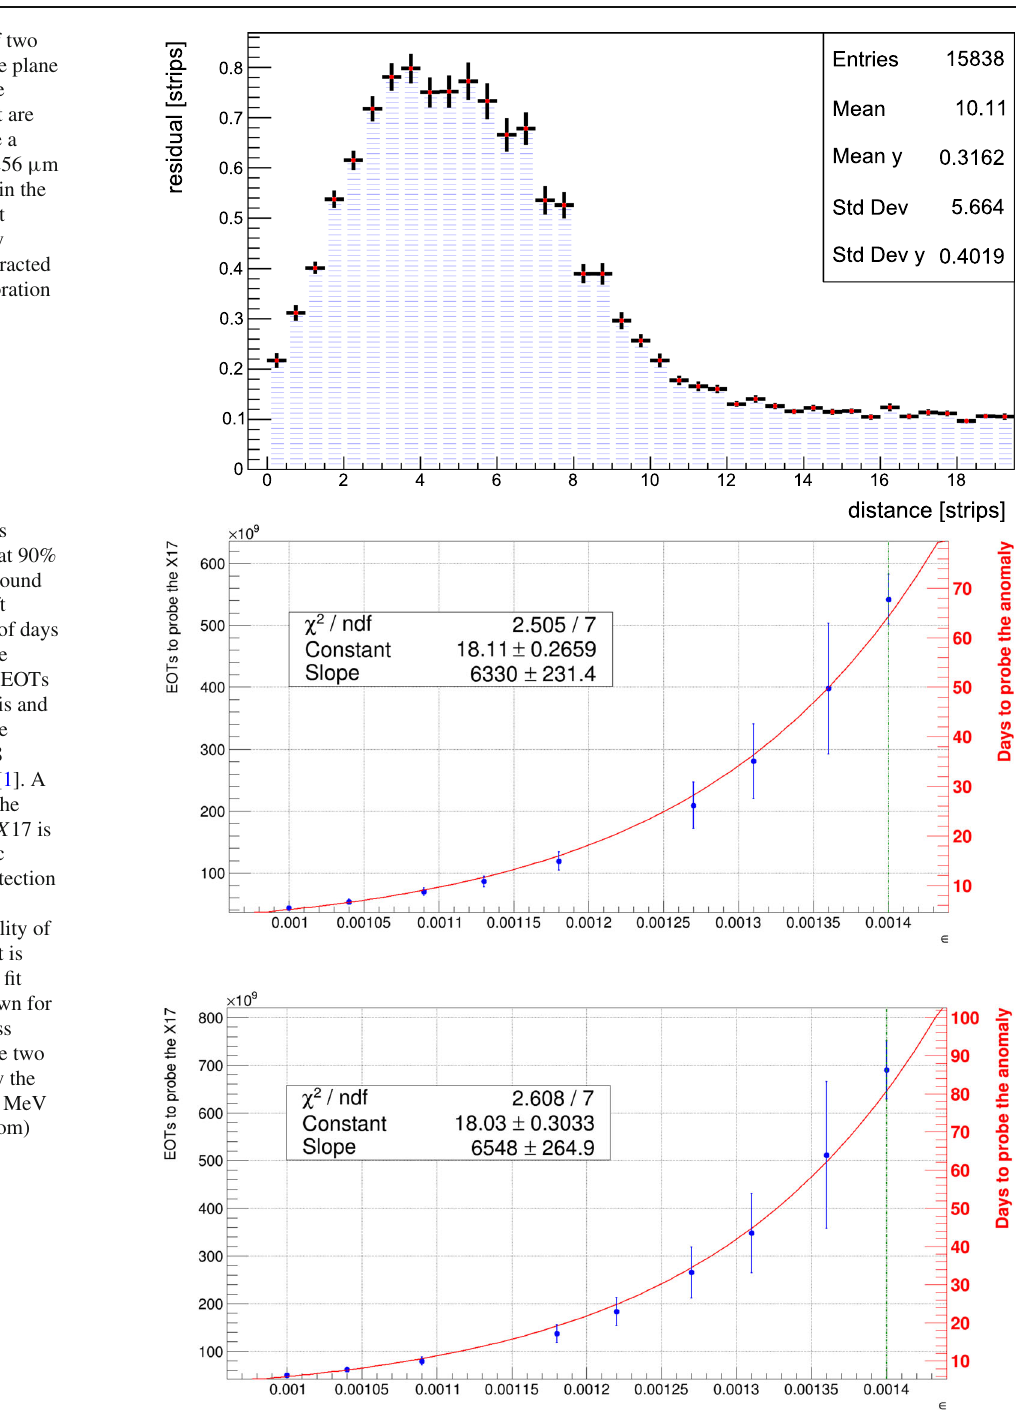
Fig. 14 Number of EOTs needed to probe the X 17 at 90% CL assuming zero background as function of (cid:2) on the left y-axis, while the number of days required to accumulate the correspondent number of EOTs is shown in the right y-axis and is based on the trigger-rate measured during the 2018 visible mode data taking [1]. A green dashed line shows the maximum (cid:2) permitted if X 17 is interpreted as protophobic gauge boson [44]. The detection efficiency for high (cid:2) is dominated by the probability of X 17 to exit the dump as it is shown by the exponential fit (red line). The plot is shown for the two most relevant mass scenarios suggested by the two experiments conducted by the ATOMKI group, i.e. 16.7 MeV (top) and 17.0 MeV (bottom)